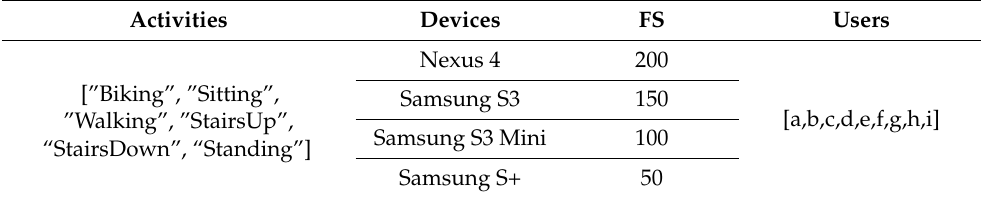
Table 8. Heterogeneity dataset (D H ) characterized by their respective attributes.